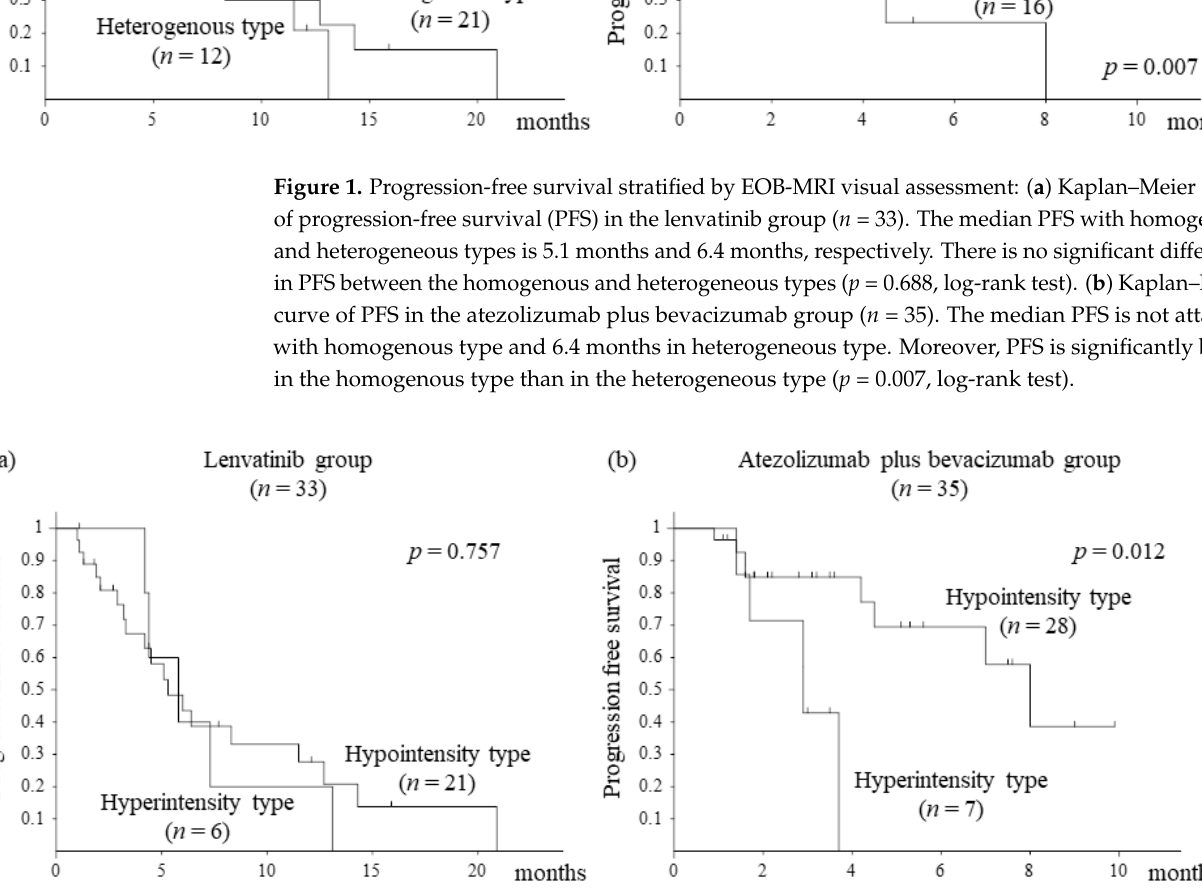
Figure 2. Progression-free survival (PFS) stratified by relative enhancement ratio: ( a ) Kaplan–Meier curve of PFS in the lenvatinib group ( n = 33). The median PFS with hypointensity and hyperintensity types is 5.3 months and 6.4 months, respectively. There is no significant difference in PFS between the hypointensity and hyperintensity types ( p = 0.757, log-rank test). ( b ) Kaplan–Meier curve of PFS in the atezolizumab plus bevacizumab group ( n = 35). The median PFS with hypointensity type and hyperintensity type is 8.0 months and 2.9 months, respectively. Additionally, PFS was significantly better in the hypointensity type than in the hyperintensity type ( p = 0.012, log-rank